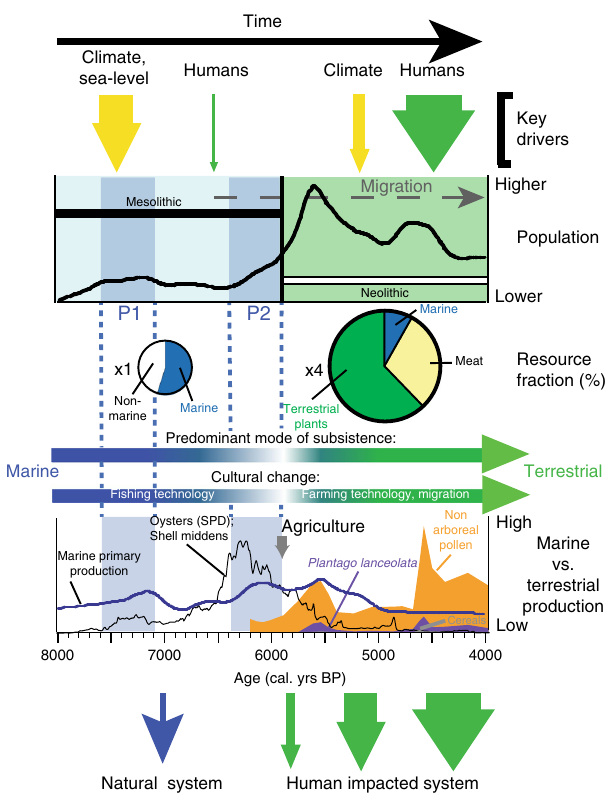
Fig. 4 Conceptual model illustrating the complex population-culture- environment interrelationships in Southern Scandinavia during the late Mesolithic and early Neolithic (the Holocene thermal maximum). Relative size of Mesolithic and Neolithic populations are based on the four-fold difference in population in period P2 (ca. 6400 – 5900 BP; i.e. x1) and Neolithic (ca. 5900 – 4000 BP; i.e. x4) from the three Scandinavian population curves 7 (Fig. 2f). Resource fraction represents the contributions of marine and terrestrial food sources to diet based on stable isotope measurements ( δ 13 C, δ 15 N and δ 2 H) on Danish archaeological remains 10, 47 ; n = 14 for Kongemose, n = 12 for Ertebølle, n = 42 for earlier Neolithic (ca. 5900 – 5000 BP) and n = 18 for later Neolithic (ca. 5000 – 4000BP). For hydrogen n = 4 for Mesolithic and n = 8 for Neolithic. Anthropogenic impact on terrestrial (and coastal) systems increasingly supplants natural (e.g. climatic) variability as the dominant driver of ecosystem change under technological, socio-cultural (including migration) and demographic development in the Neolithic as reliance on marine resources